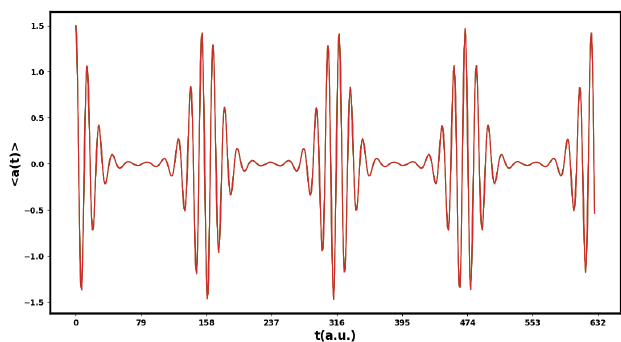
Figure 3. The expectation value (cid:104) a ( t ) (cid:105) plotted as a function of time for coherent quantum state in the presence of dissipation γ c = γ m = 0.00001 a.u. and nonlinearities k c = k m = 0.01 a.u. The bath temperature corresponding to each mode is T = 0.